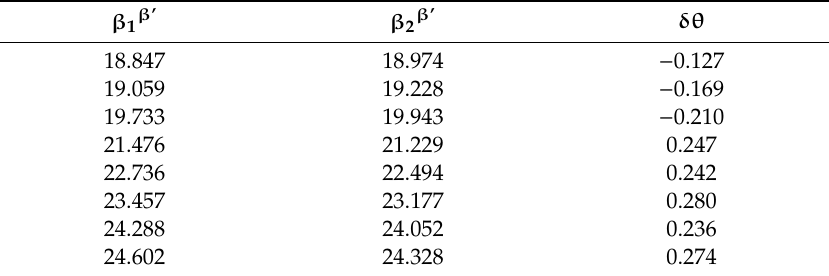
(cid:48) (cid:48) and β 2 β peaks, and their shift.